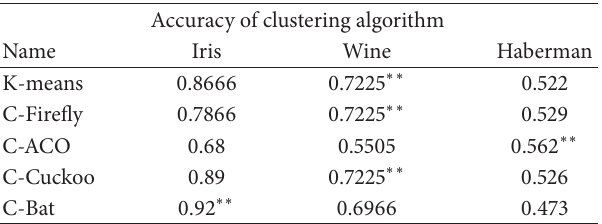
Table 15: Performance of clustering results of image segmentation using different clustering